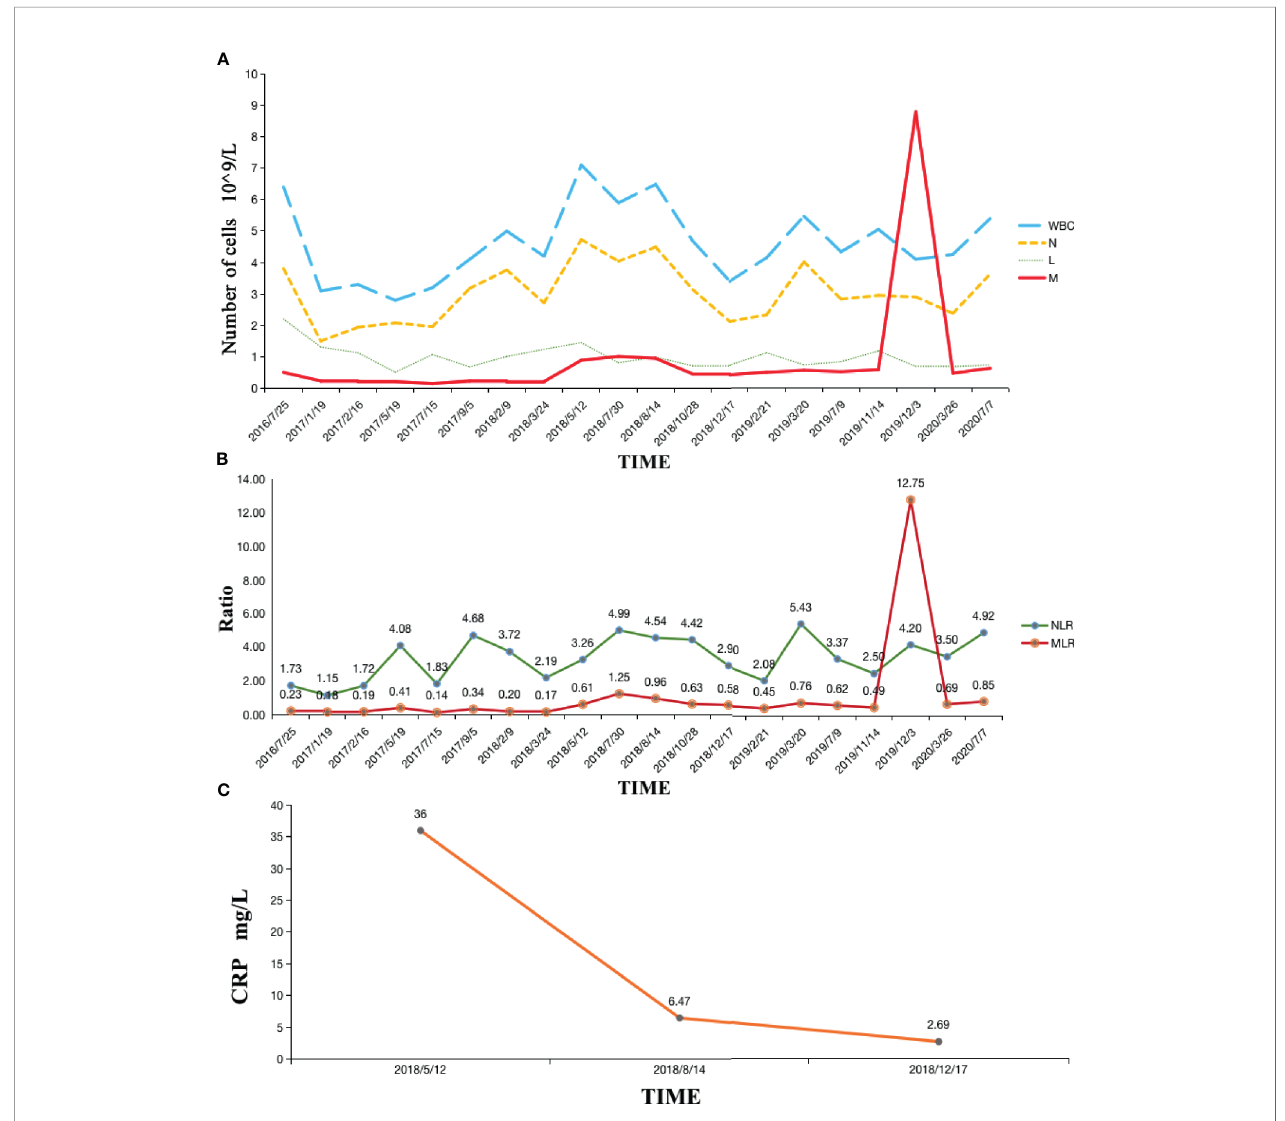
FIGURE 3 | (A) Hematological indexes remained stable except the number of monocytes peaked during radiotherapy; (B) MLR remained stable and then peaked during radiotherapy; (C) Serum CRP level signi fi cantly reduced after Camrelizumab and RT. WBC, white blood cell; N, neutrophil; L, lymphocyte; M, macrophage; MLR, macrophage-to-lymphocyte ratio; NLR, neutrophil-to-lymphocyte ratio; CRP, C-reactive